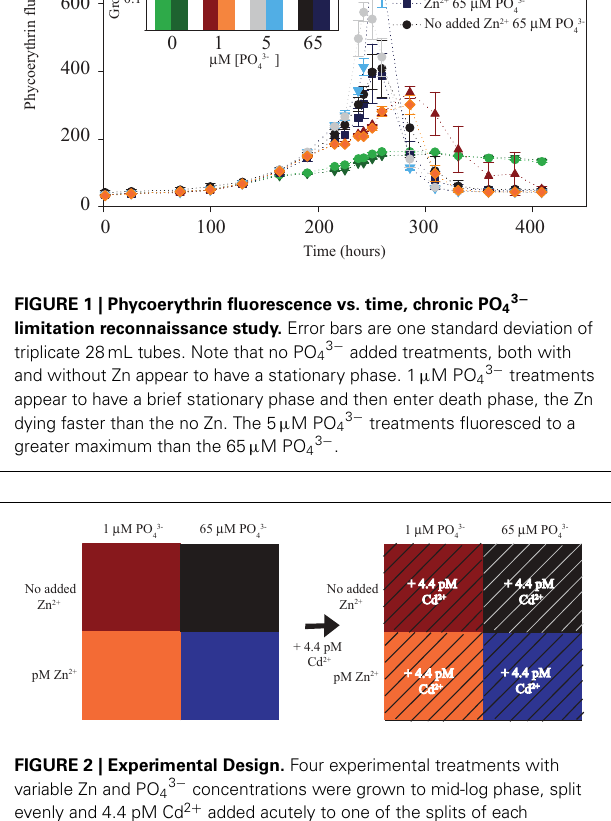
FIGURE 2 | Experimental Design. Four experimental treatments with variable Zn and PO 43 − concentrations were grown to mid-log phase, split evenly and 4.4 pM Cd 2 + added acutely to one of the splits of each